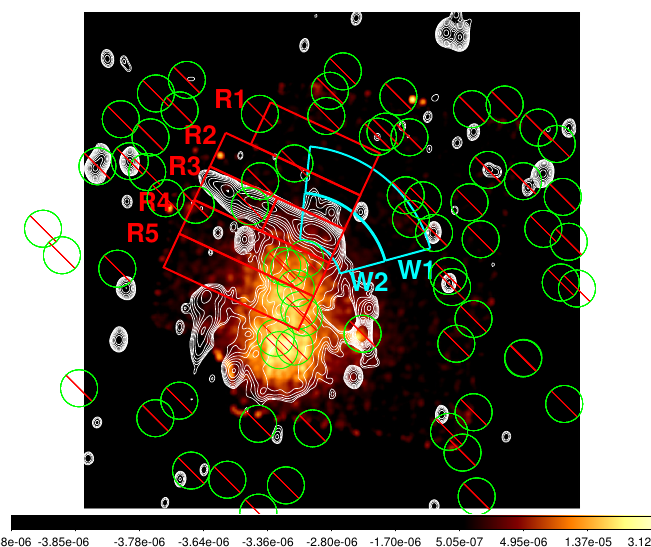
Figure 1. An X-ray image of 1RXS J0603.3+4214 taken by Suzaku XIS3 in the 0.5–8.0 keV band (colors) overlaid with 1.16–1.78 GHz radio contours by WSRT from [6]. Red boxes are regions used to produce the temperature profile across the relic.